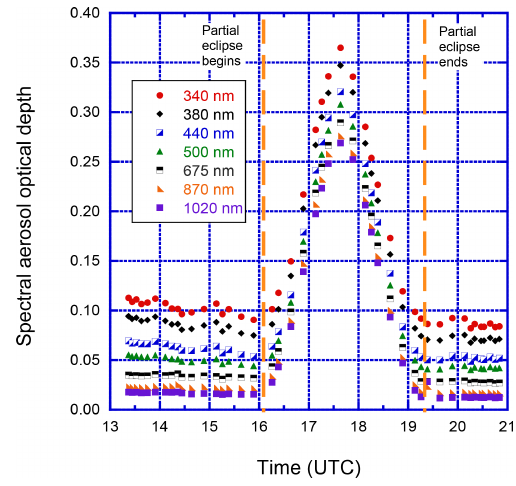
Figure 3. Eclipse circumstance at the NASA Goddard Space Flight Center (GSFC; lat 38.99, long − 76.84) on 25 December 2000 be- tween 16:04:13 and 19:16:25UTC. The maximum AOD during the eclipse occurs at the maximum obscuration of 0.42, which results in a change of ∼ 0 . 28 for AOD at 500nm compared to data be- fore and after the solar eclipse. Utilizing the NASA Solar Eclipse database, the AOD measurements are removed between the partial eclipse first contact and partial eclipse last contact as denoted by the vertical dashed